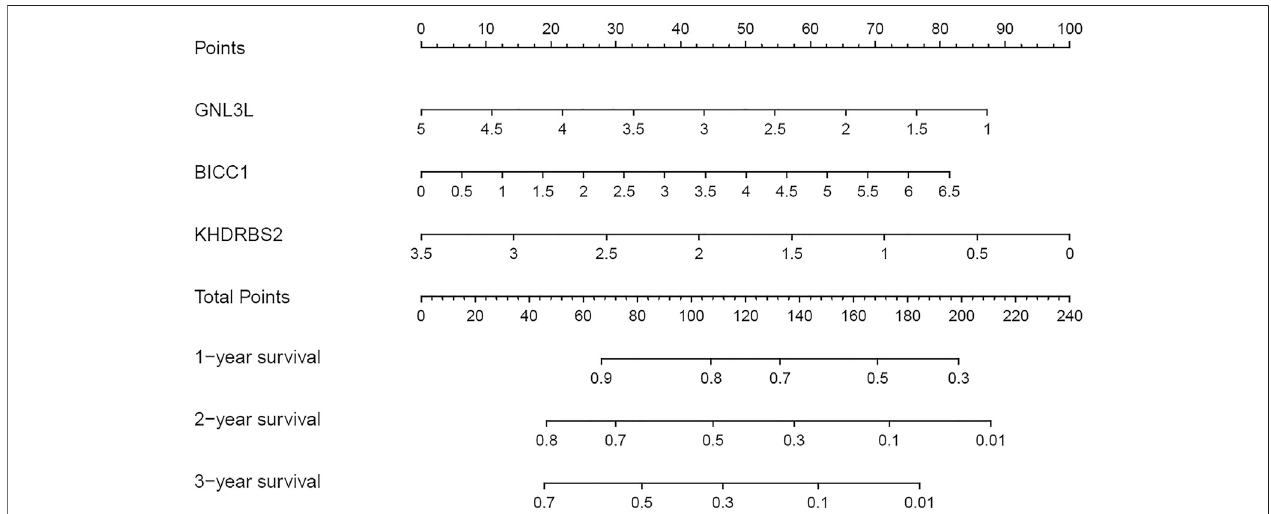
FIGURE 8 | Nomogram for predicting 1, 2, and 3-years OS of GBM patients in the TCGA cohort.